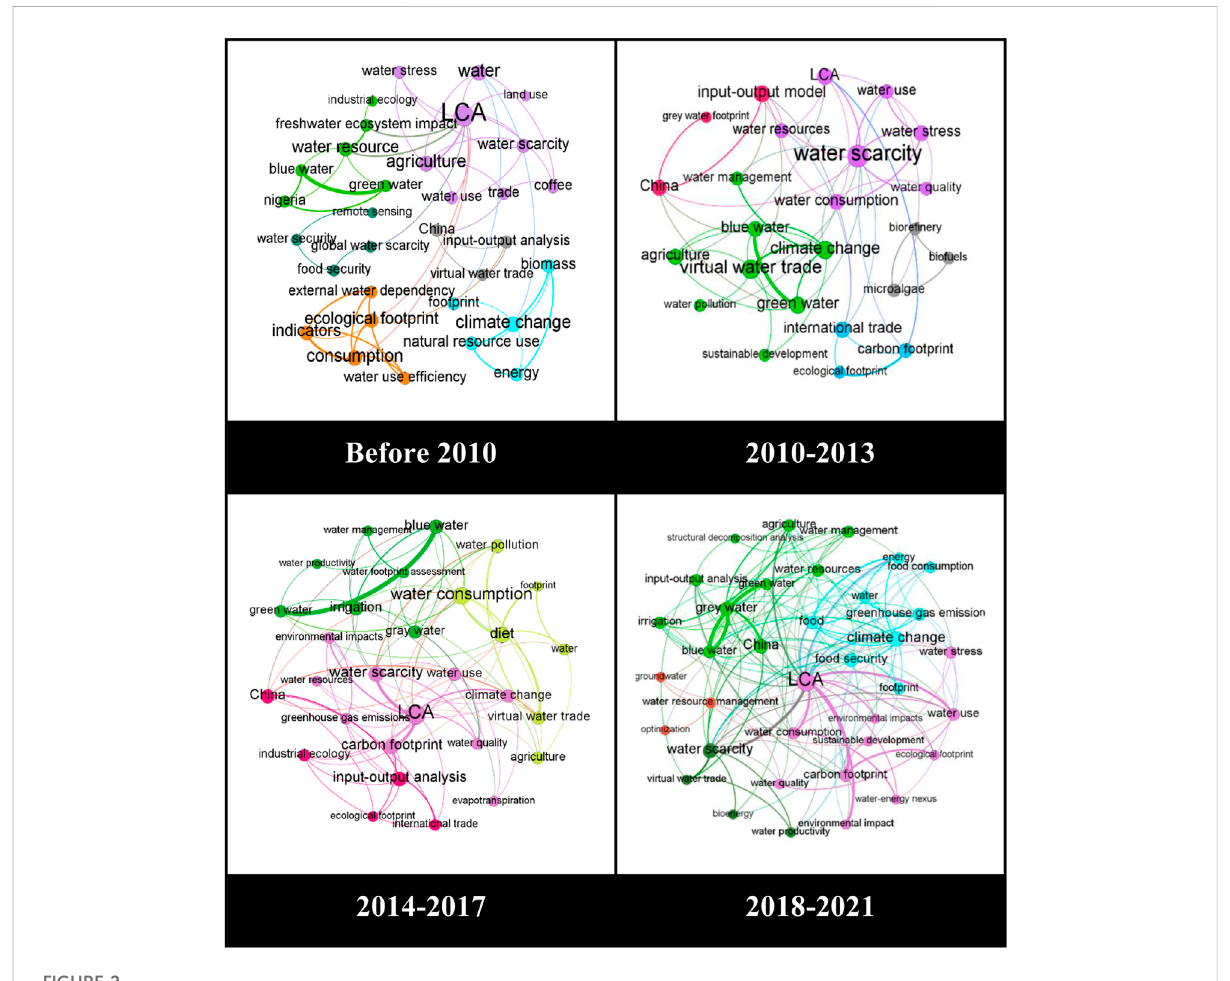
The evolutionary co-words network of water footprint from